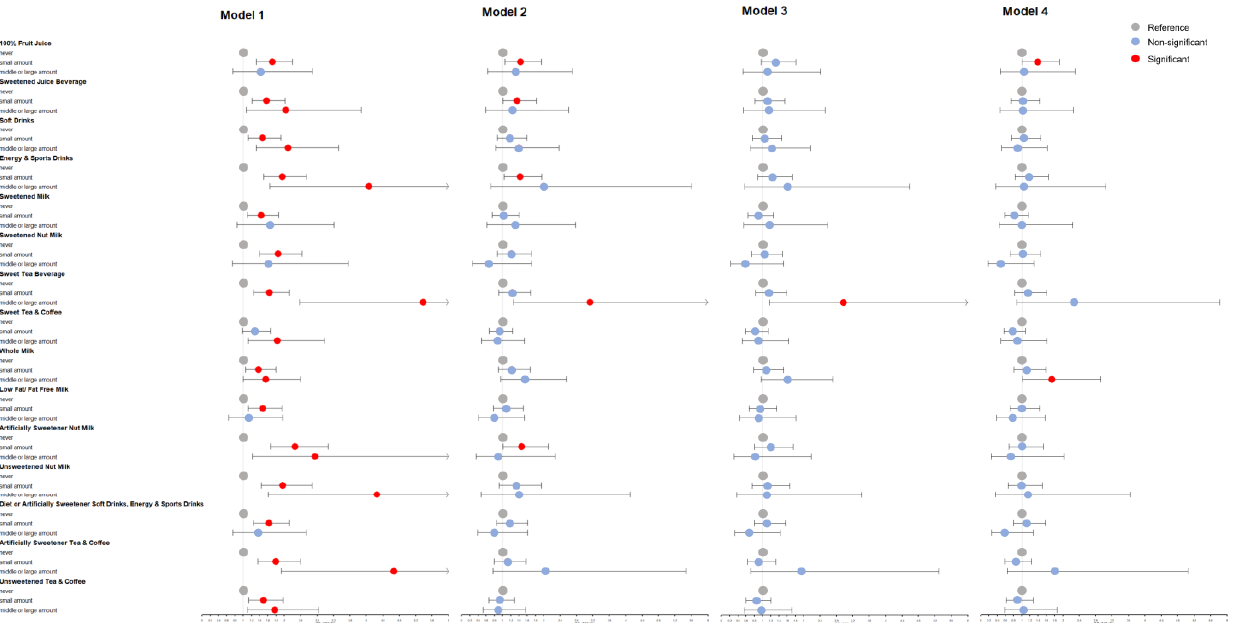
Figure 3. Association between different types of beverage intake amount and male pattern hair loss (MPHL). Model 1 had no adjustment for confounders; Model 2 adjusted: age, education level, BMI, smoking status, alcohol intake, family history, hair dyeing/perming/bleaching/relaxing, sleep time and physical activity; Model 3, based on model 2, further adjusted consumption of vegetables, meats, eggs, beans and bean products, oils and fats, deep fried food, sugar and honey, sweets and ice cream; Model 4, based on model 3, further adjusted PTSD.